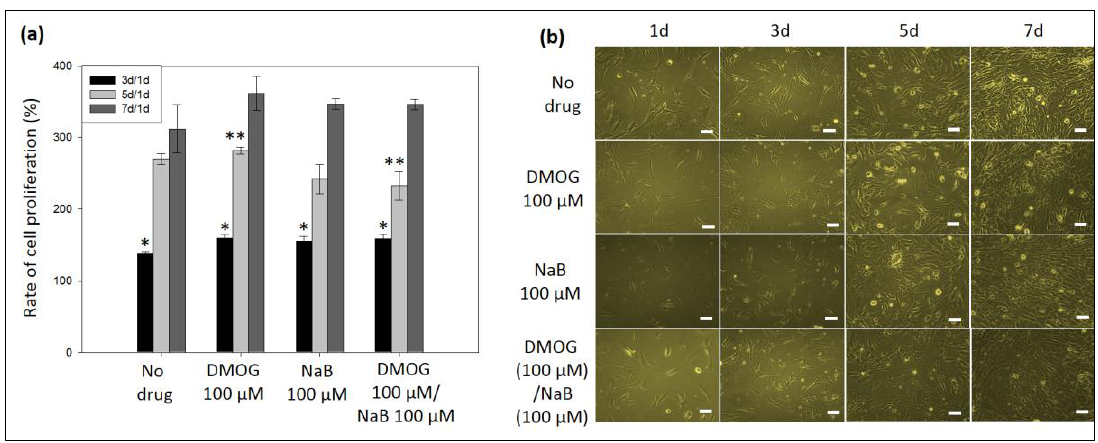
Figure 6. ( a ) Effect of MC3T3 cell proliferation with bolus delivery of drugs (DMOG 100 µM, NaB 100 µM, NaB 100 µM + DMOG 100 NaB 100 µM) on well plate, ( b ) images of MC3T3 cells on well plate by light microscopy (scale bar = 50 µm).